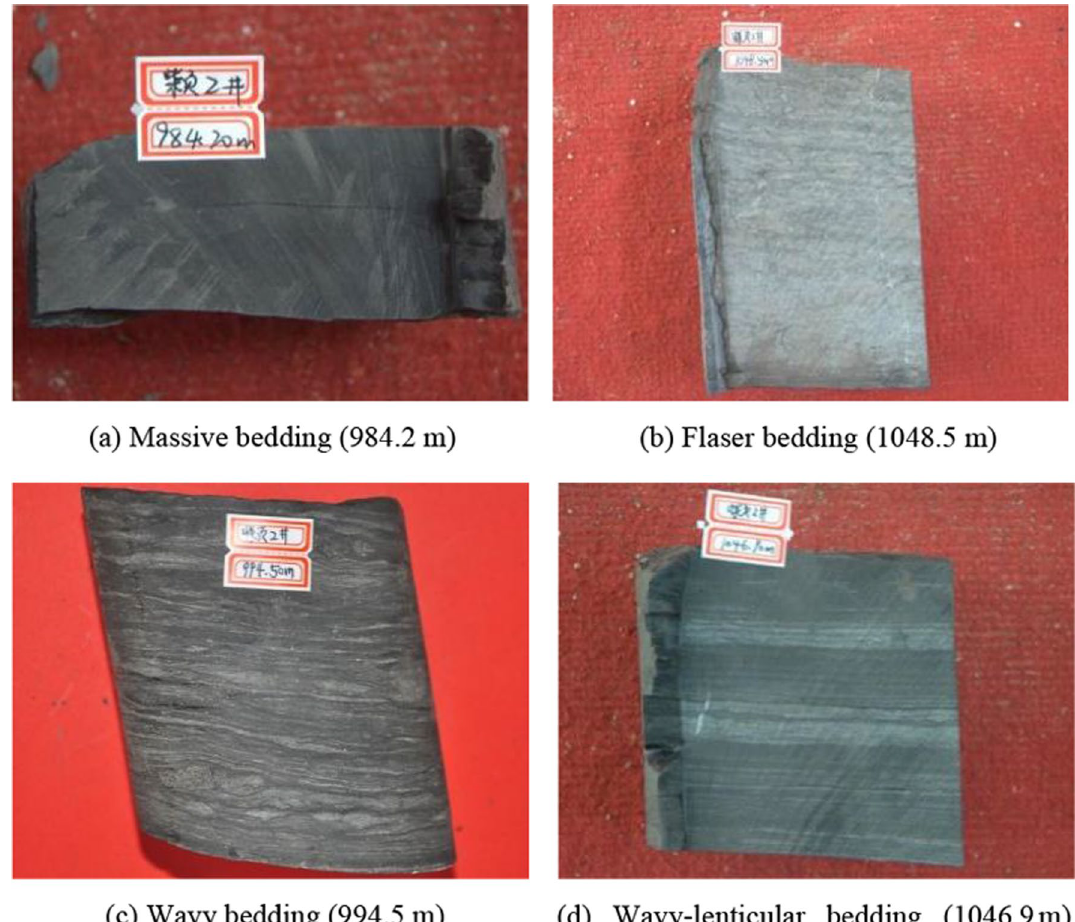
Fig. 4 Structural characteristics of the Carboniferous Hurleg Formation shale (from the Chaiye 2 well) (Li and Yu